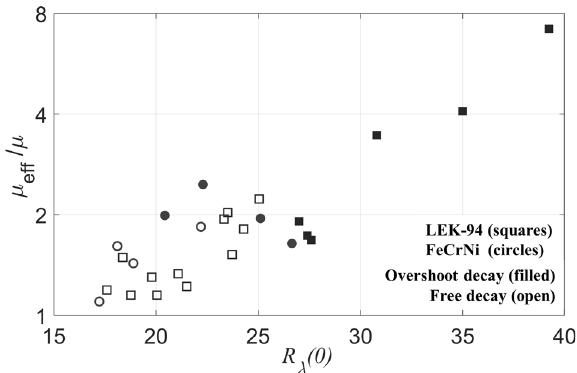
Fig. 3 Effective viscosity ratio μ eff / μ (log scale) at t 0 as a function of R λ